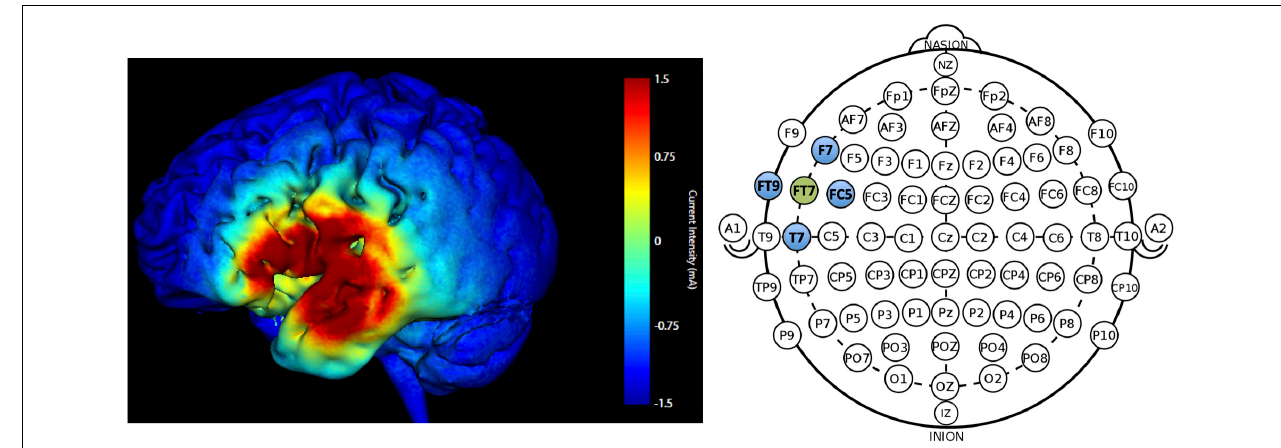
FIGURE 3 | Predicted current modeling simulation at 1.5 mA intensity for electrode placement at FT7 (anode; green) and F7, T7, FC5, FT9 (cathode electrodes; blue). The color legend indicates current intensity (warmer colors = higher current intensity; max = 1.5 mA).